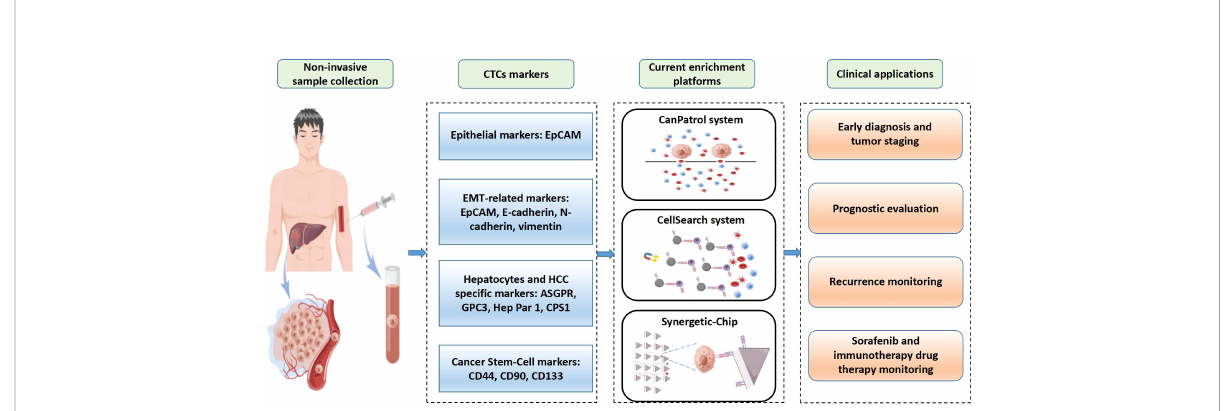
FIGURE 2 Overview of clinical applications of circulating tumor cells (CTCs) in hepatocellular carcinoma (HCC). CTCs are obtained from patients ’ blood samples in a non-invasive way. HCC CTCs are primarily isolated based on their unique biological markers. CellSearch is the only FDA-approved system for CTCs detection used clinically. CanPatol and CTC-chip are other CTCs detection systems. CTCs represent an independent factor for early diagnosis and tumor staging, prognostic evaluation, recurrence monitoring, and drug therapy